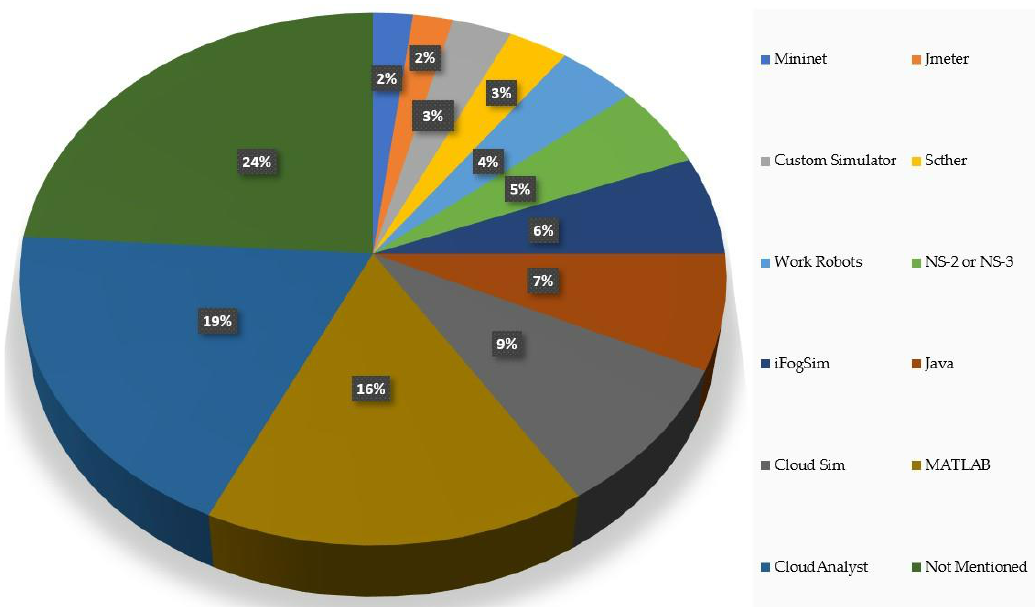
Figure 5. Percentage-wise tools for implementing load balancing in fog computing .